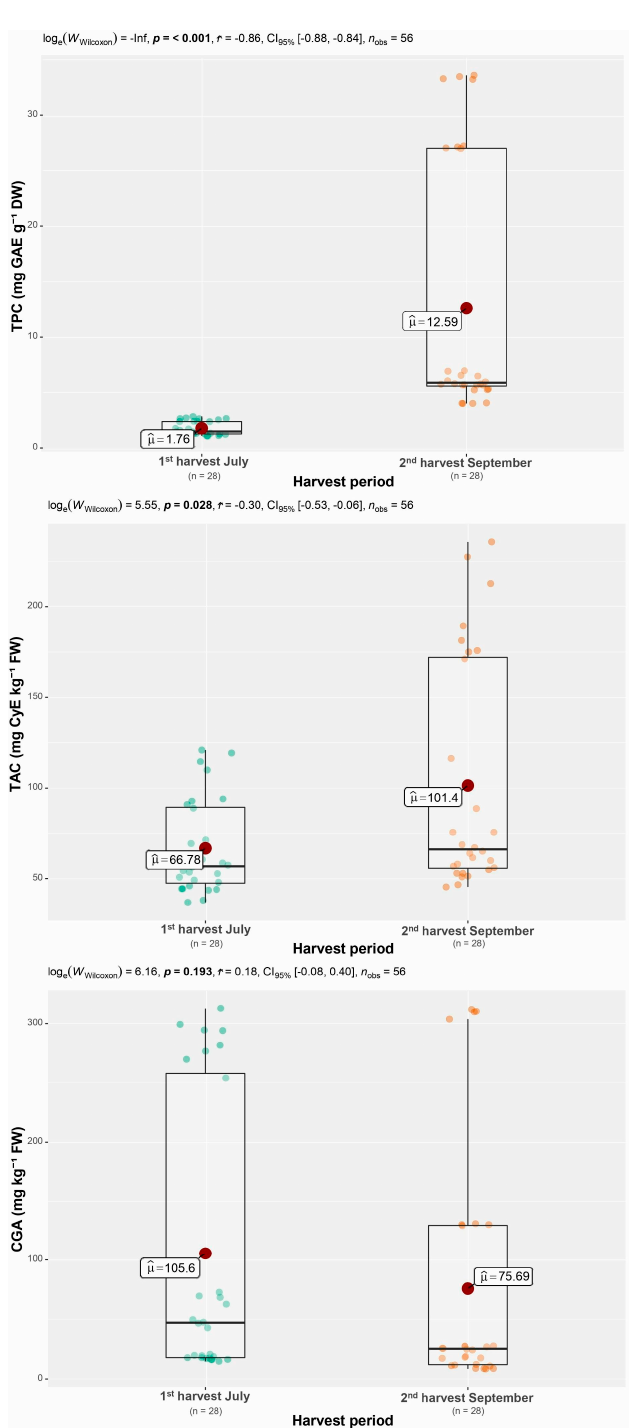
Figure 2. Statistical differences in total polyphenol content (TPC), total anthocyanin content (TAC), and chlorogenic acid content (CGA) in potatoes between two different harvest periods.